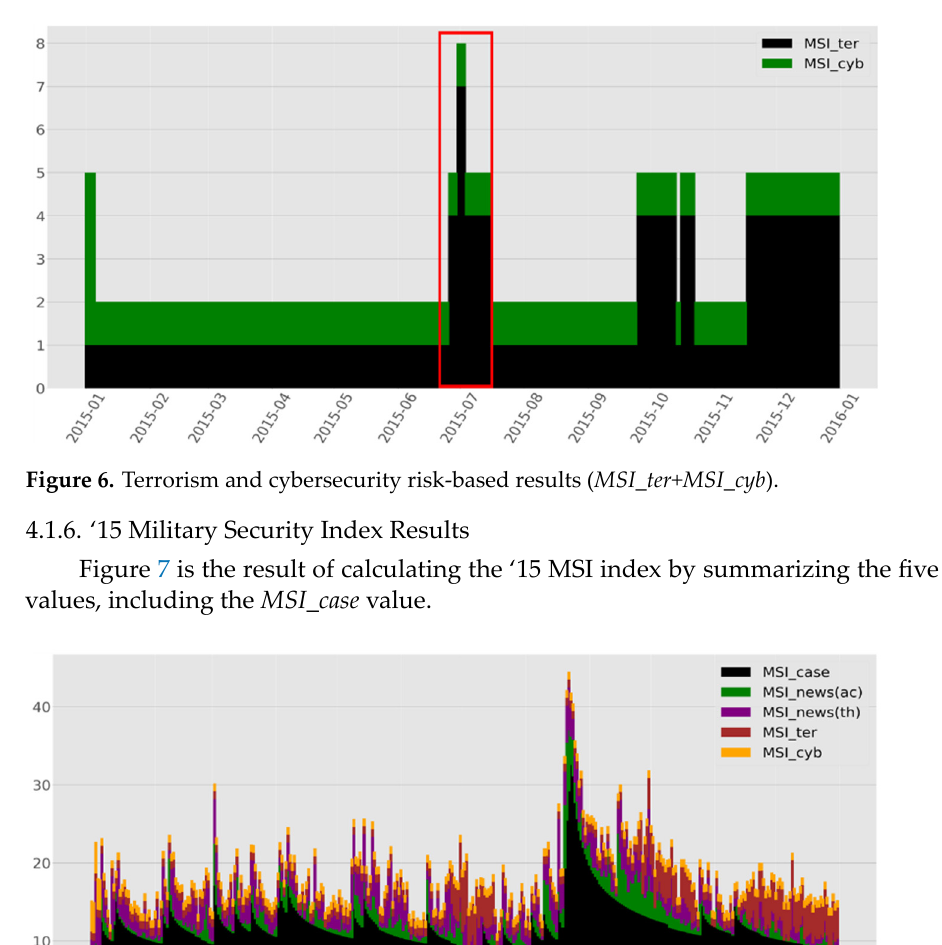
Figure 5. Keywords related to threat-based results ( MSI_news th ).